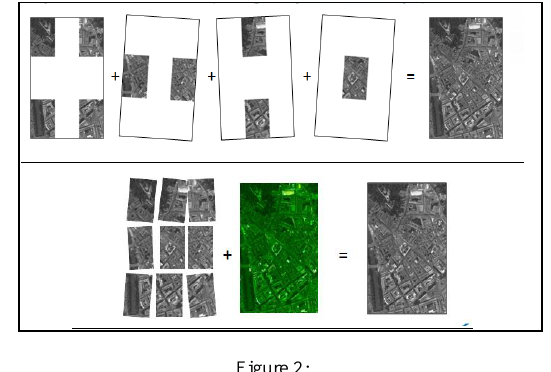
Figure 2: Stitching image segments into one large image is a core skill being accomplished by one of two approaches. Above is the initial assembly based on the overlaps within the 4 separate panchromatic image segments. Below is a simultaneous adjustment of all image tiles using their overlaps as well as the green color-channel. A complex consideration concerns the effects of temperature on the deformation of the individual cones. Key publications about stitching are by Gruber & Ladstädter (2006, 2012) and Ladstädter et al. (2010) .